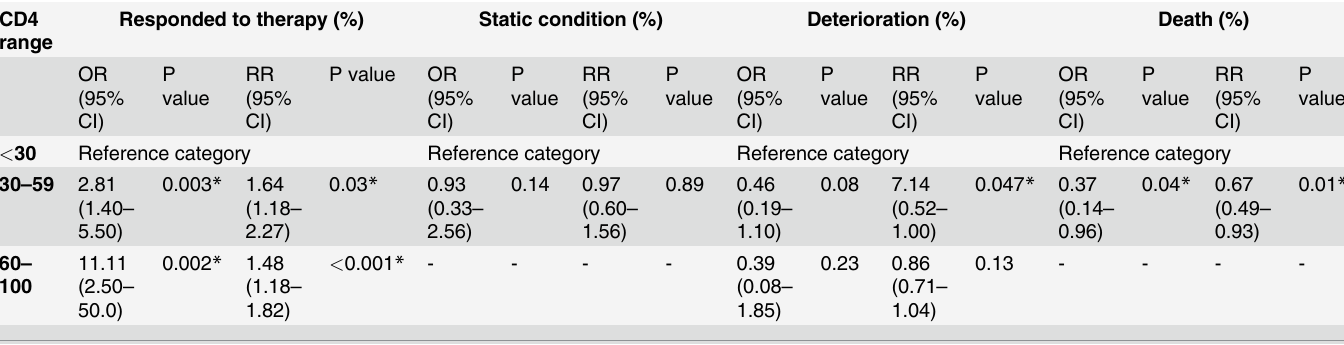
Table 5. Association between the prognosis of CMV end organ diseases (EODs) with CD4 count among participating HIV positive patients (N =